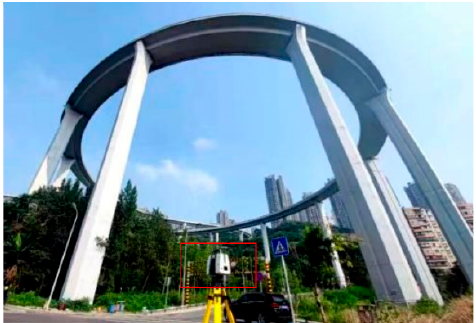
Figure 6. Sujiaba Bridge TLS data acquisition in scan station 1. The red box shows the Leica P50 3D laser scanner.